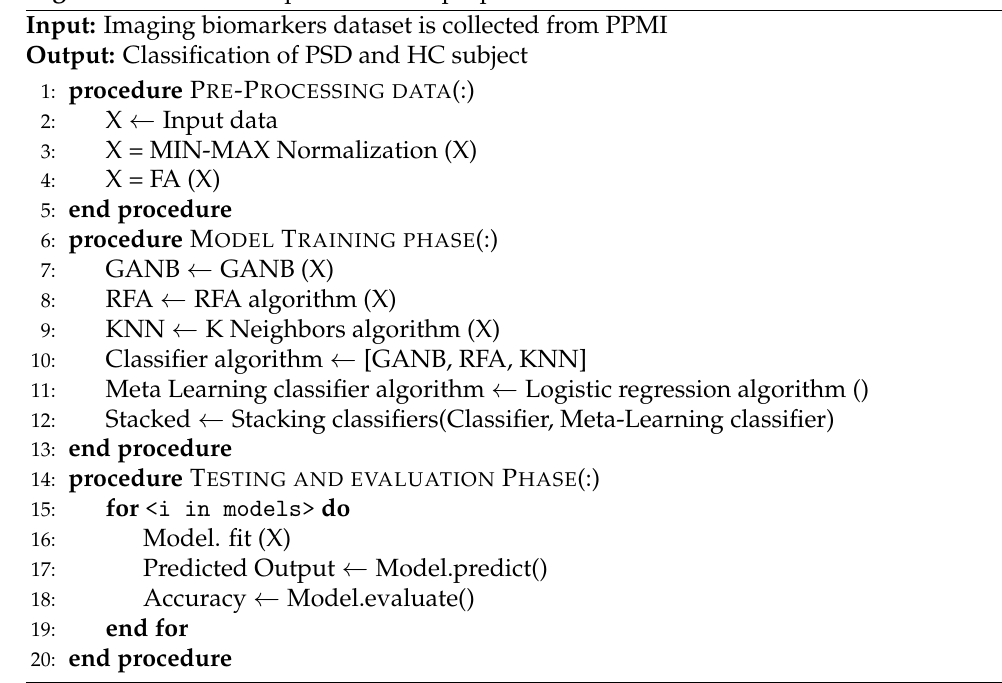
Algorithm 2 Execution process of the proposed